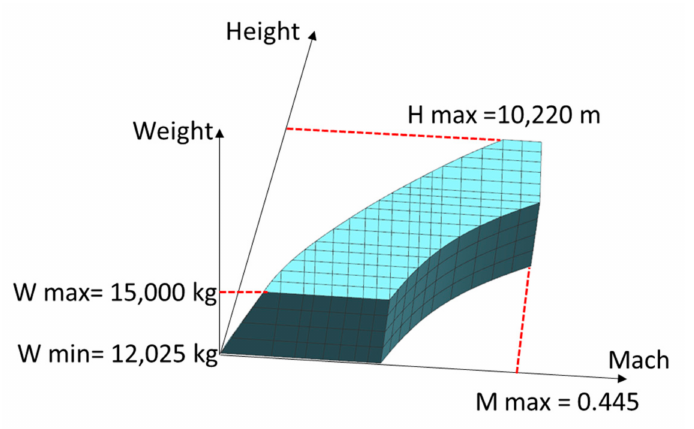
Figure 15. Discretization of feasible range of flight regimes of the regional